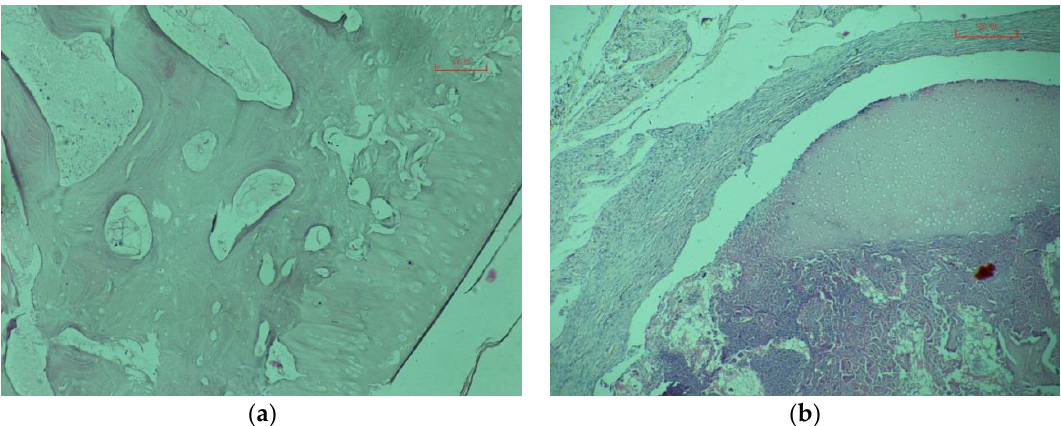
Figure 7. Micrograph of bone X400: The 110 days after transplantation, control animal ( a ); 110 days after transplantation, experienced animal ( b ).